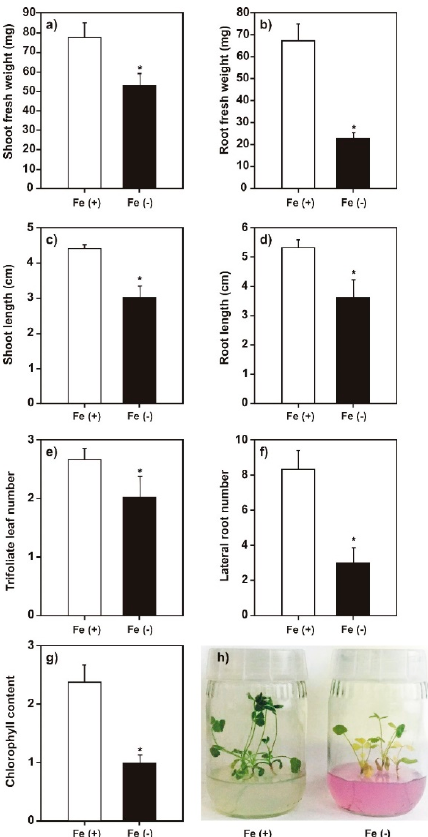
Figure 1. Effect of iron deprivation on Medicago truncatula growth. The M. truncatula plants cultured under iron sufficiency (control) or iron deficiency for 14 days. ( a ) Shoot fresh weight; ( b ) root fresh weight; ( c ) shoot length; ( d ) root length; ( e ) trifoliate leaf number; ( f ) lateral root number; and ( g )